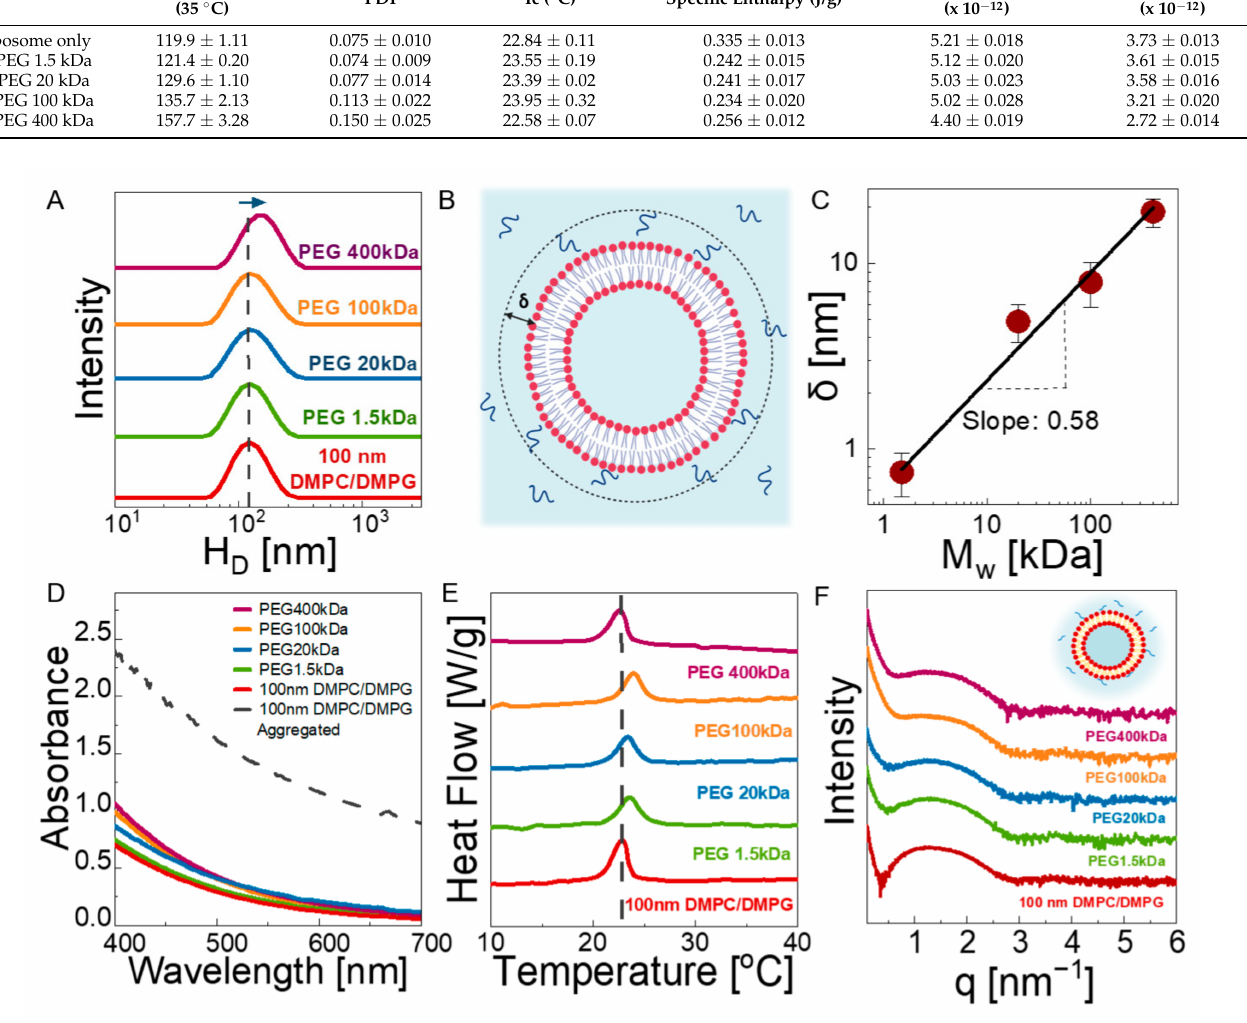
Figure 2. ( A ) Hydrodynamic diameter of 2 wt% 100 nm DMPC/DMPG liposomes mixed with 2 wt% PEG solutions with molecular weights of 1.5, 20. 100, and 400 kDa at 35 ◦ C ( B ) Schematic representation of the attachment of PEG chains on lipid bilayer surfaces. δ represents the thickness of the adsorbed layer. ( C ) Molecular weight dependence of δ in PEG–liposome solutions. The data are averaged over three separate estimates; error bars represent one standard deviation. ( D ) UV-vis spectroscopy results of 2 wt% 100 nm DMPC/DMPG liposomes mixed with 2 wt% PEG solutions at 35 ◦ C. The dashed line represents aggregated vesicles after 1 week of preparation. ( E ) DSC results of neat 2 wt% 100 nm DMPC/DMPG liposomes and 2 wt% 100 nm DMPC/DMPG liposomes mixed with 2 wt% PEG solutions at 35 ◦ C. ( F ) SAXS results of neat 2 wt% 100 nm DMPC/DMPG liposomes and mixed with 2 wt% PEG solutions at 35 ◦ C. The inset shows the attachment of PEG chains onto lipid bilayer. All measurements in A, D, E, and F were repeated three times to ensure reproducibility of the